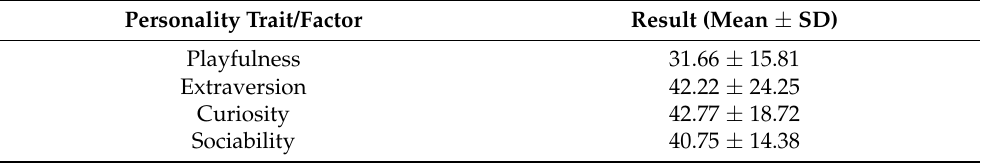
Table 7. Mean values for personality factors of the two European wolf groups.